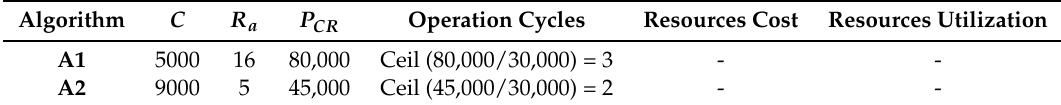
Table 2. The instance in a large